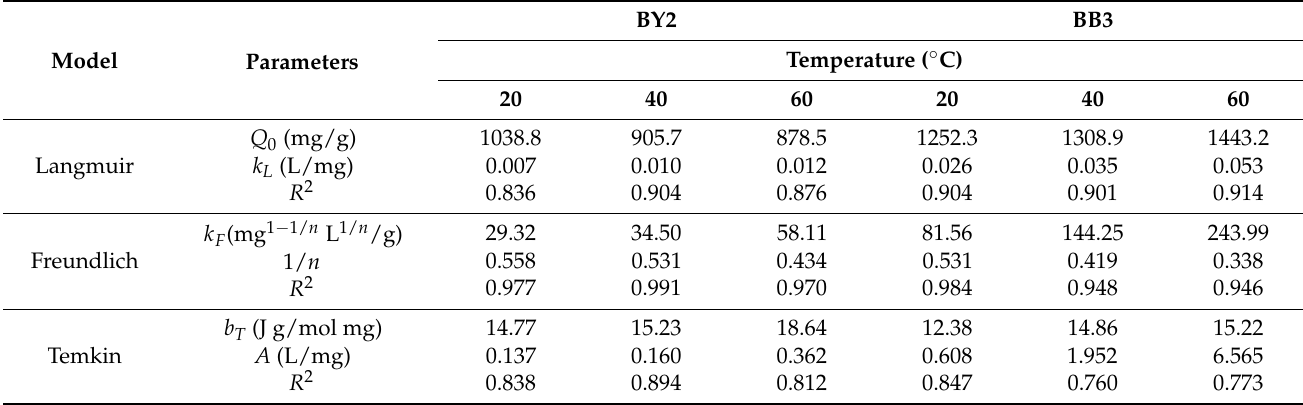
Figure 4. Equilibrium adsorption data in ( a ) BY2-C/SiO 2 and (b) BB3-C/SiO 2 systems at different temperatures (where: LR—linear regression, Non-LR—non-linear regression). Table 2. Parameters of the Freundlich, Langmuir, and Temkin isotherm models calculated for the adsorption systems at 20–60 ◦ C using linear